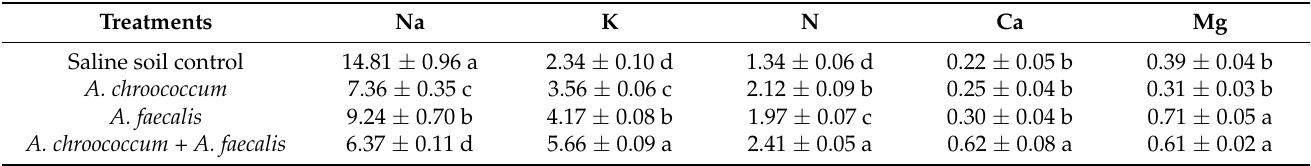
Table 3. Minerals’ contents (mg g − 1 DW) in canola plant inoculated with Azotobacter chroococcum, Alcaligenes faecalis, and their co-inoculation under salinity-stress conditions. Bars show means of three independent replications (n = 3) ± standard error. Means with the same letter are not significantly different at p < 0.05. DW: dry weight.